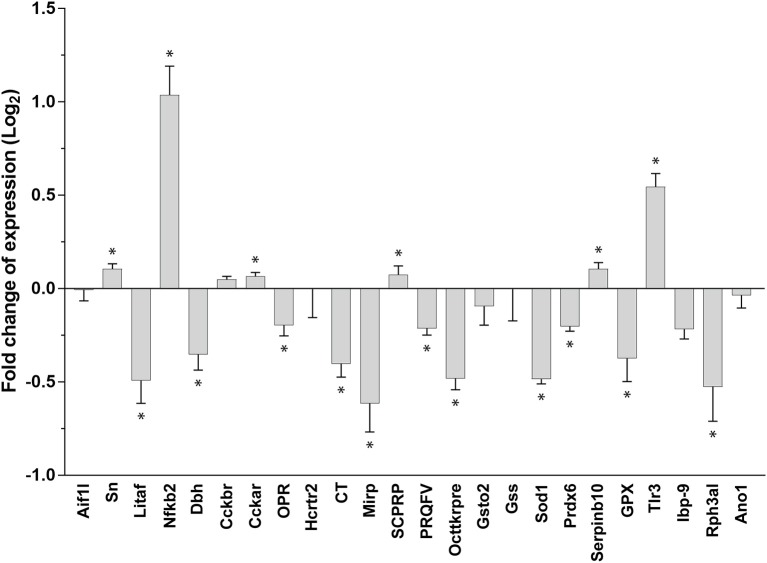
Relative gene expression using real-time RT-qPCR. Fold changes of expression (log2, error bar: 95% confidence interval). A differential pattern of up- and downregulation of 24 genes in the octopus gastric ganglion of animals infected by Aggregata octopiana (“high” level) emerged when compared (“high”/”low”) with their expression in samples taken from octopus where the parasite load from Aggregata was defined as “low.” Asterisks mark significant changes; see text for details and Table 3.